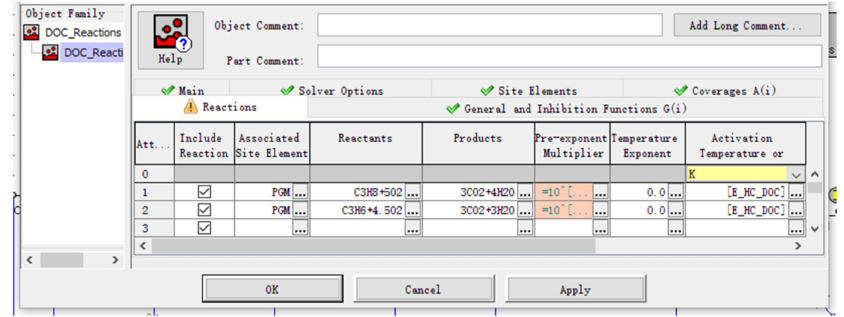
Figure 8. Modeling of the DOC internal chemical reactions.